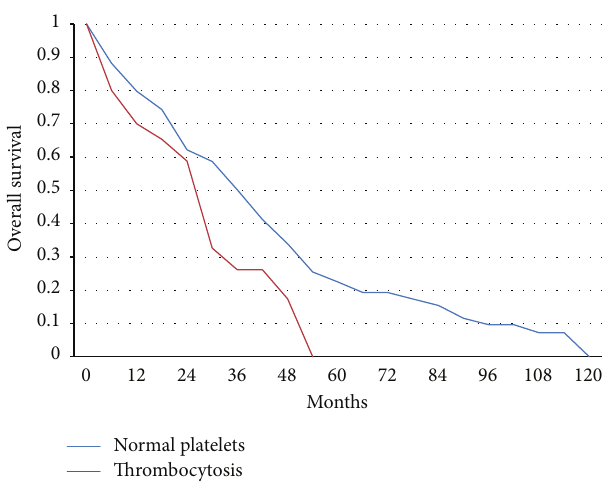
Figure 2: Kaplan-Meier progression free survival curves in months from the diagnosis of metastatic disease of patients with normal platelet counts (150–350 × 10 9 /L) versus patients with thrombocy- tosis. LogRank test 𝑃 = 0.008